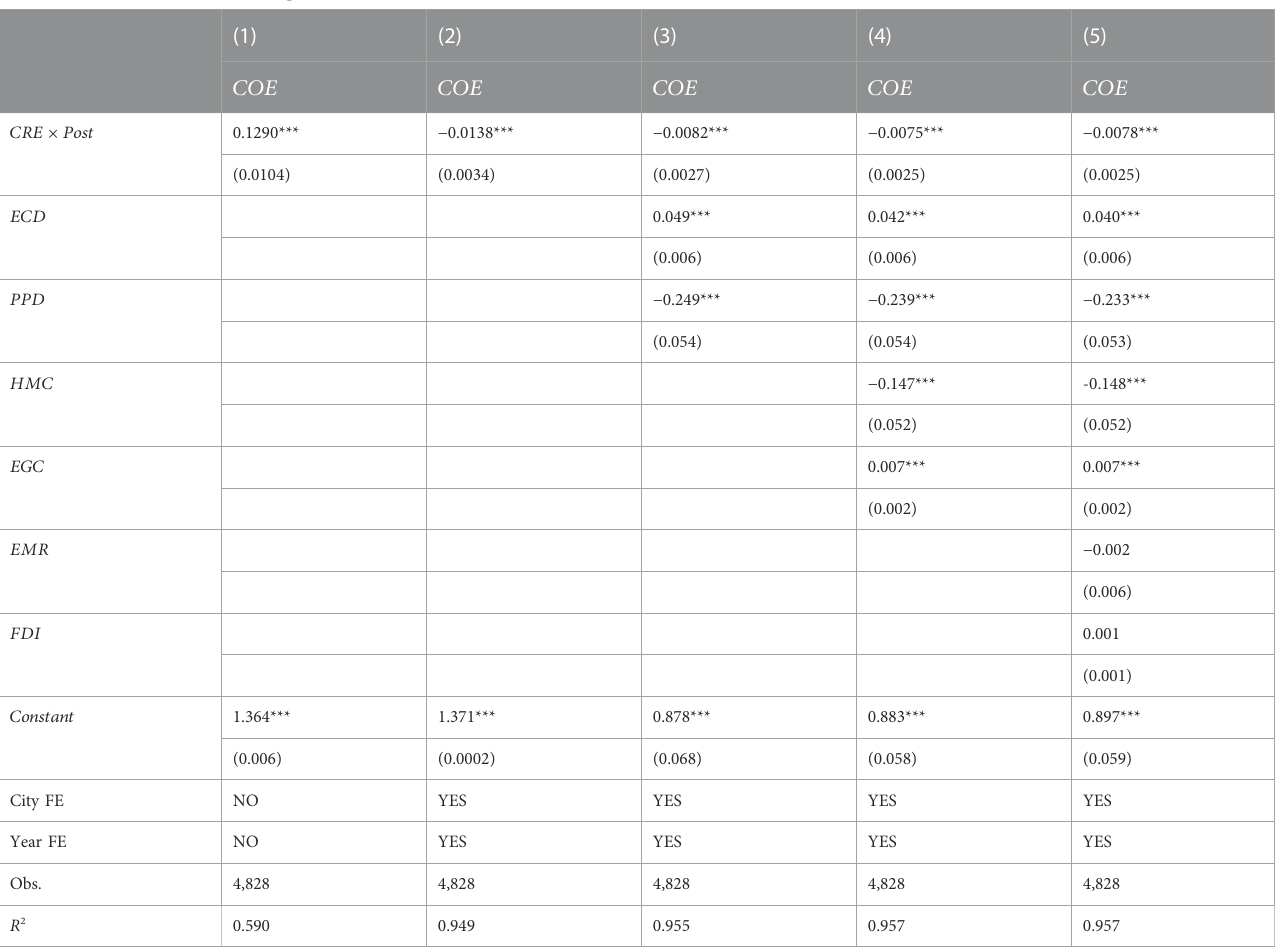
TABLE 2 The result of benchmark